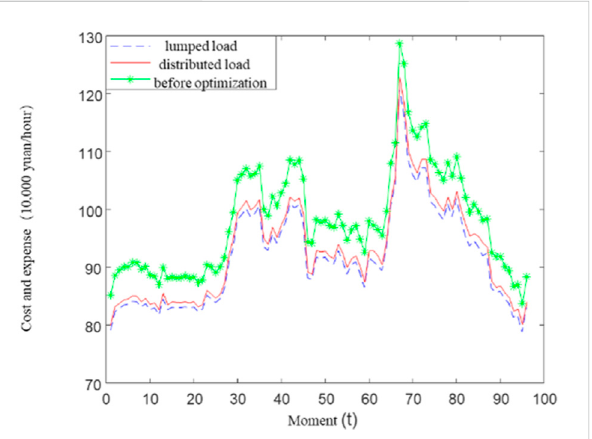
FIGURE 10 The generating cost curves of the AI dispatching and the real system in distributed load